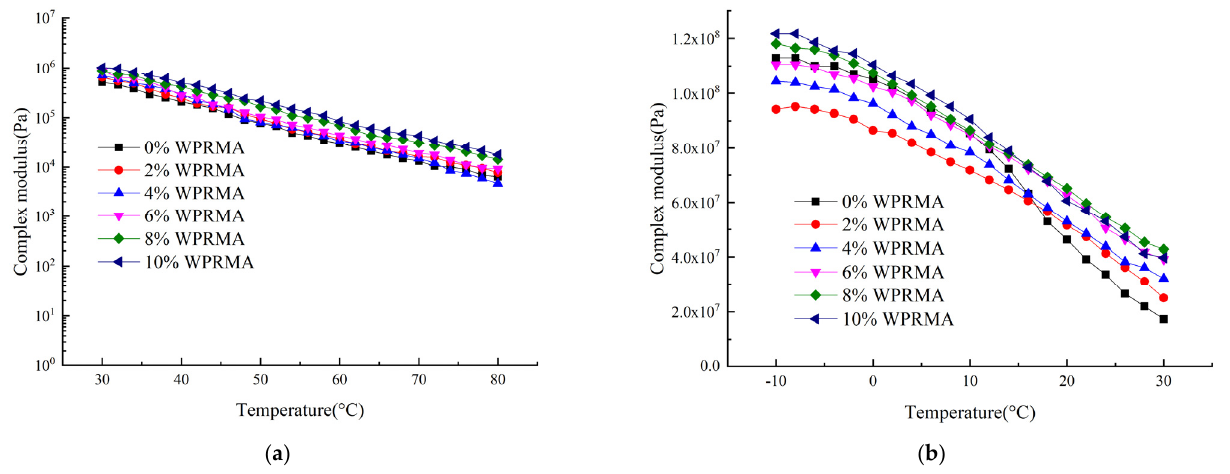
Figure 8. Temperature scan curves of waste plastic/rubber-modified asphalt at: ( a ) high temperatures and ( b ) low temperatures.